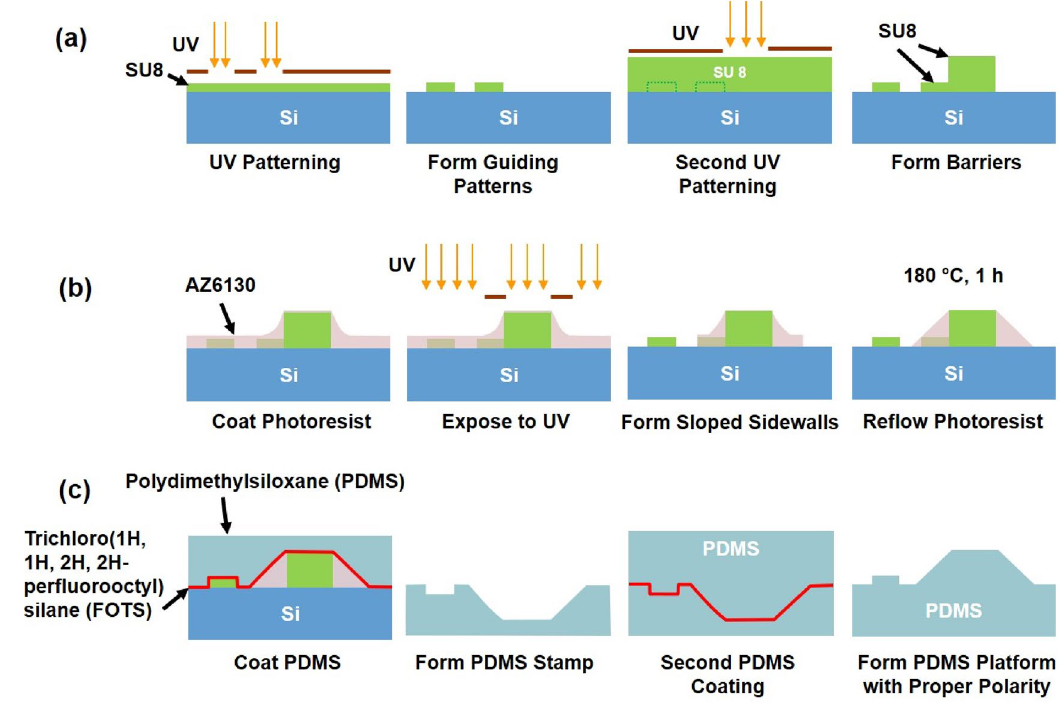
Figure 1. Schematic of fabrication technology of PDMS platform with barriers and guiding patterns. ( a ) Photolithography to fabricate grating and arrows in channels with different barrier heights. ( b ) Barriers with sloped sidewalls fabricated by photolithography and photoresist reflow. ( c ) Replication of PDMS platform from stamp with barriers and patterns of grating and arrows in